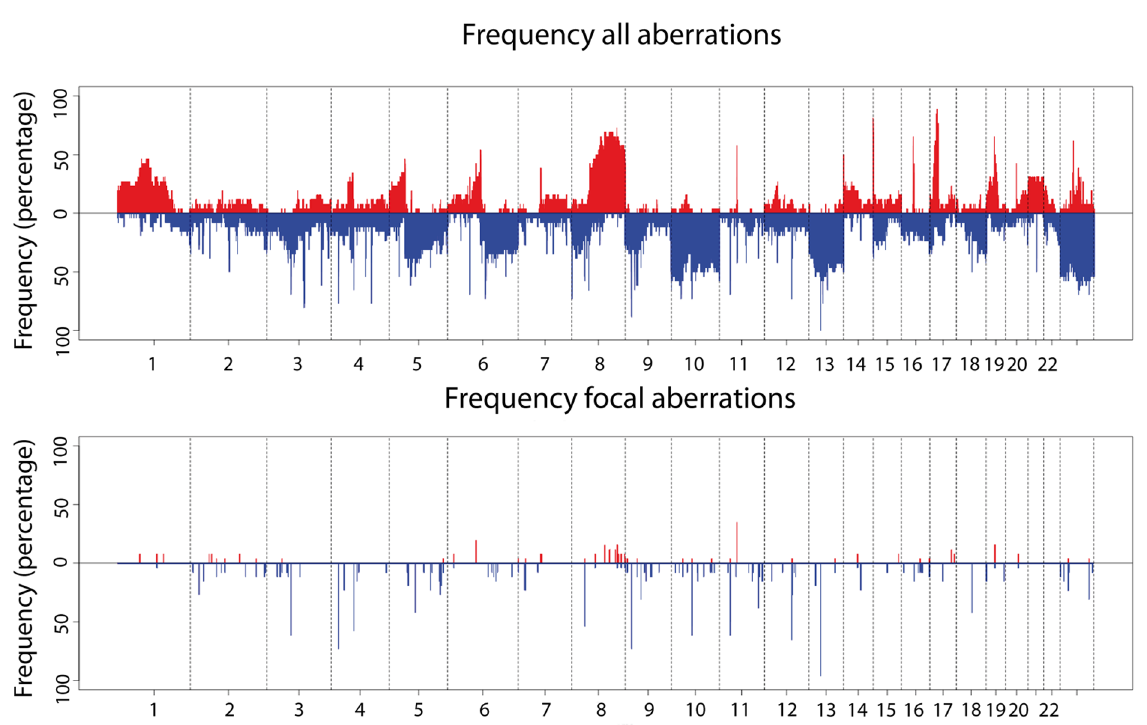
Fig. 1. Genome-wide frequency plot of all copy number aberrations (top) and of focal copy number aberrations (bottom) in 26 osteosarcoma samples. Frequencies of gains (in red) and losses (in blue) are indicated. Vertical bars in B represent detected focal copy number aberrations ( , 3 Mb).